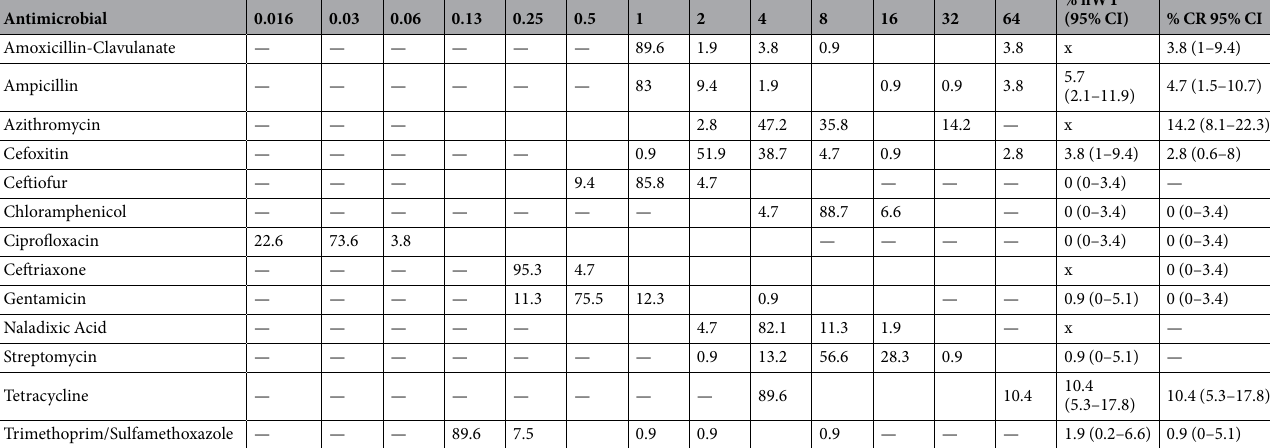
Table 3. Distribution of MICs and resistance among Salmonella isolates ( n = 106) from faecal samples collected from rangeland goats at slaughter in Western Australia. nWT, non-wild type; CR, clinical resistance; “x” No data presented for this drug due to lack of wild, susceptible and clinical breakpoints. Cells not denoted as ‘—’ indicate MIC range available for each agent available on the Sensititre CMV3AGNF card. MICs > than highest concentration available are indicated in the shaded region. Thin vertical lines indicate EUCAST ECOFF values and Thick vertical lines indicate CLSI resistant